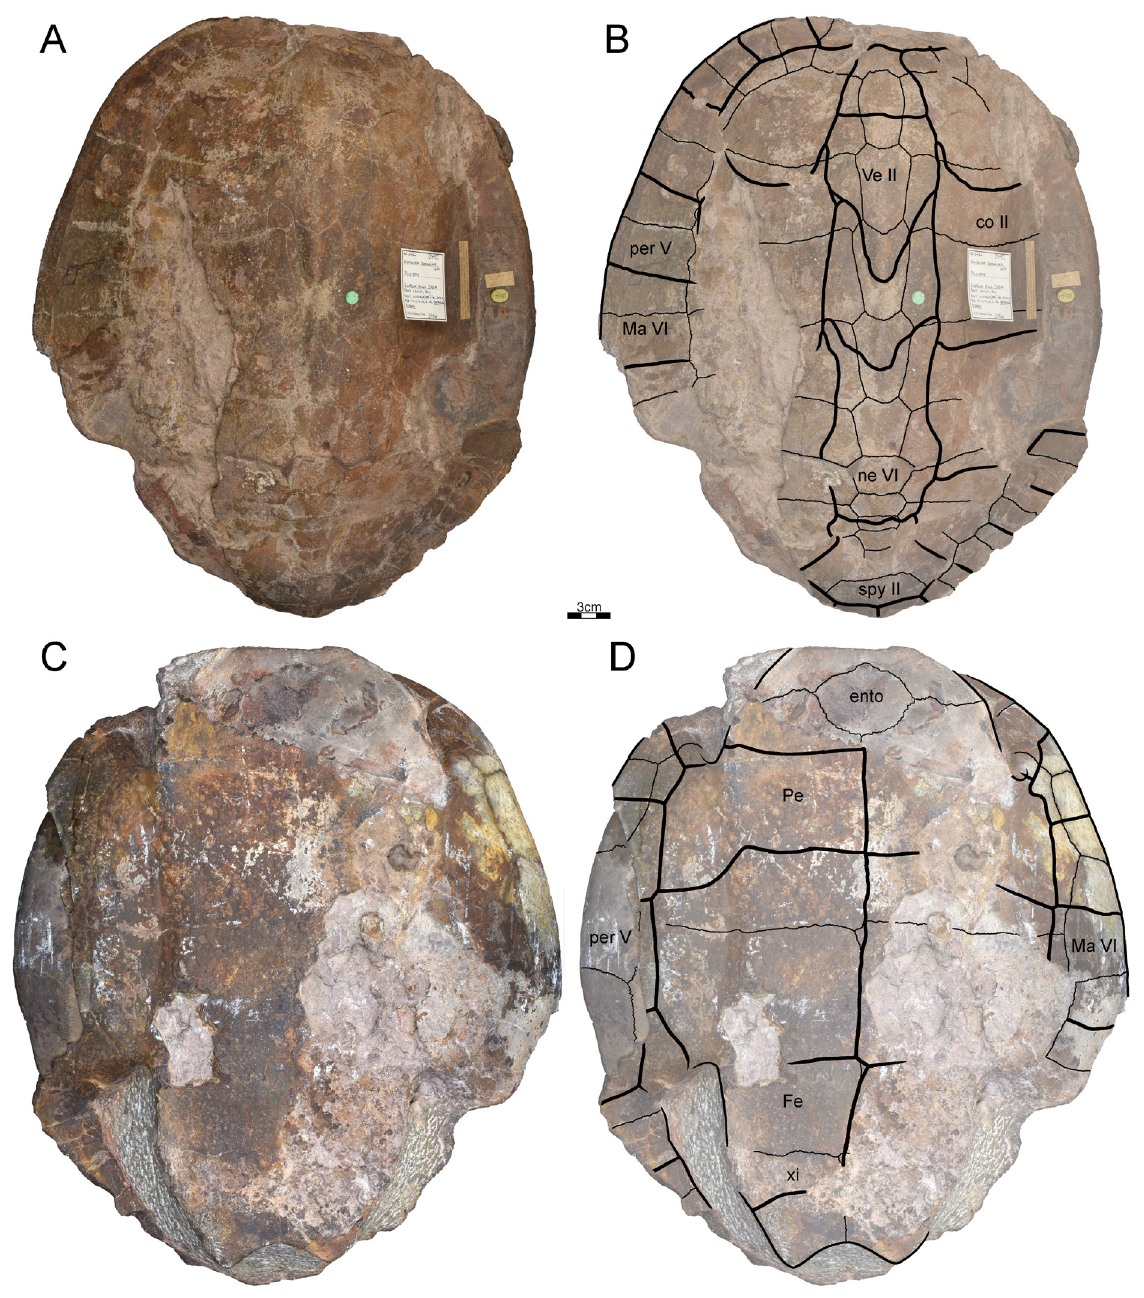
Fig. 14. BMNH 39841, holotype of Batagur durandi Lydekker, 1885, here identified as synonym of Batagur dhongoka (Gray, 1832). A . Photograph of carapace. B . Illustration of carapace. C . Photograph of plastron. D . Illustration of plastron. Scale bar: